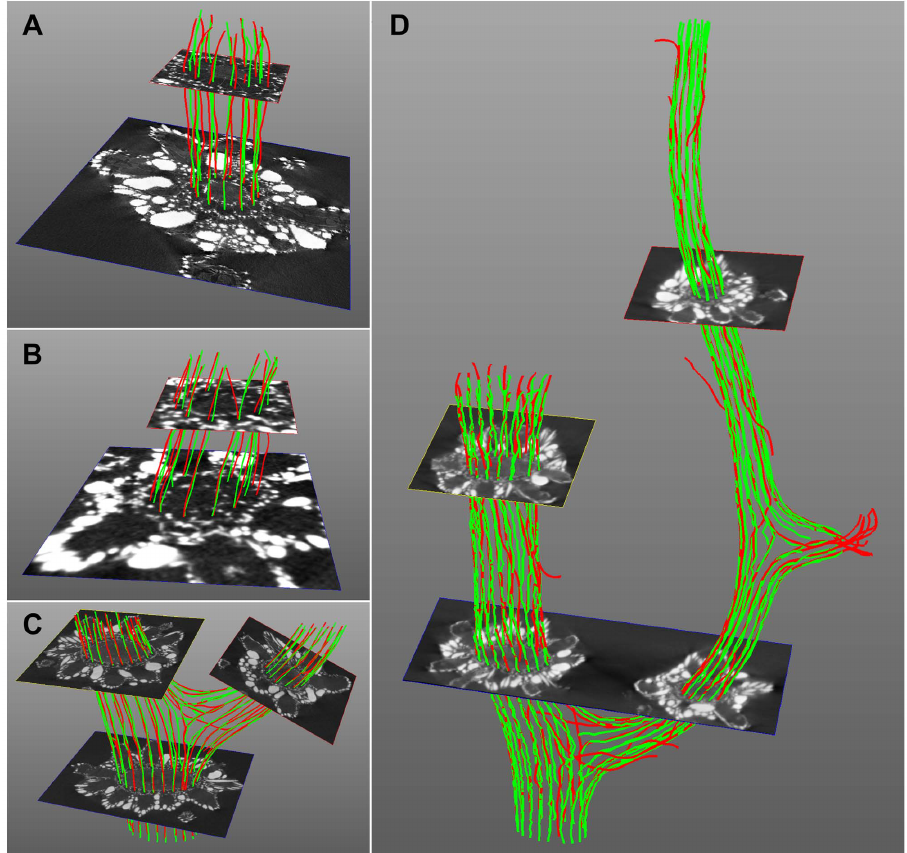
Figure 11. Extracted and reference pathways. The extracted and reference pathways are respectively displayed in red and green, together with the initialization planes in the corresponding datasets: (A) EX, (B) M1, (C) M5, (D) S3.